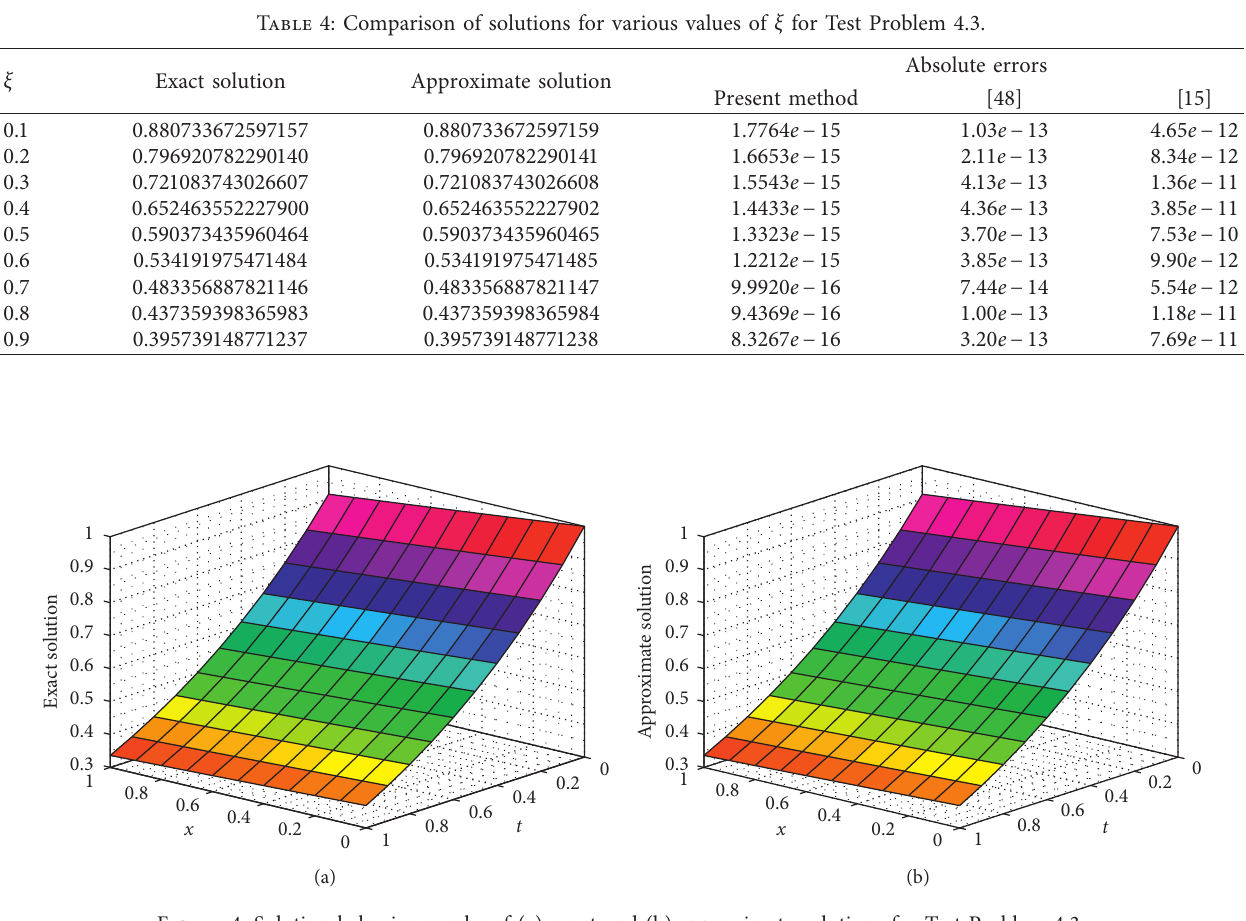
Figure 4: Solution behavior graphs of (a) exact and (b) approximate solutions for Test Problem